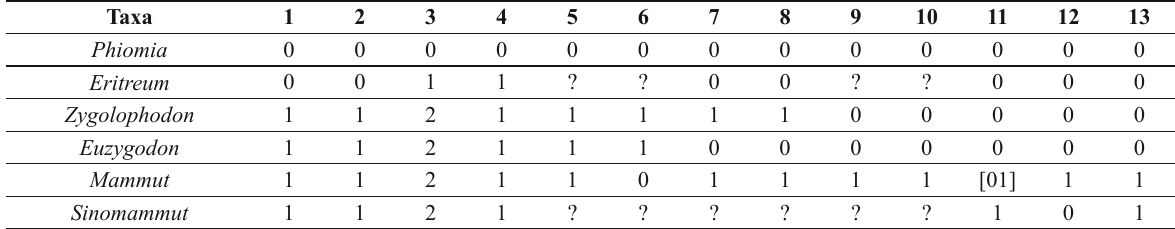
Character-taxon matrix used in the cladistic analysis of the Mammutidae, including the new taxon Sinomammut tobieni . Missing data (either due to non-preservation or because non-applicable) are coded as “?”. Dental, cranial and mandibular characters are: 1) Antero-posterior compression of lophs/lophids on molars: (0) absent (1) present; 2) Crest- like crescentoids on pretrites (0) absent (1) present; 3) Cheek tooth in use simultaneously (0) M1-M3 with other anterior molars (1) only M1-M3 (2) M1-M3 simultaneously in use; 4) Tritolophid of M (0) shortened (1) enlarged; 5) Upper 2 permanent tusks (0) shorter than lower jaw (1) longer than lower jaw; 6) Upper permanent tusks with lateral enamel band (0) absent (1) present; 7) Lower tusks shape (0) concave dorsally (1) straight; 8) Lower tusks cross section (0) fl attened (1) rounded or oval; 9) Upper tusks laterally divergent (0) little divergent (1) very divergent; 10) Upper